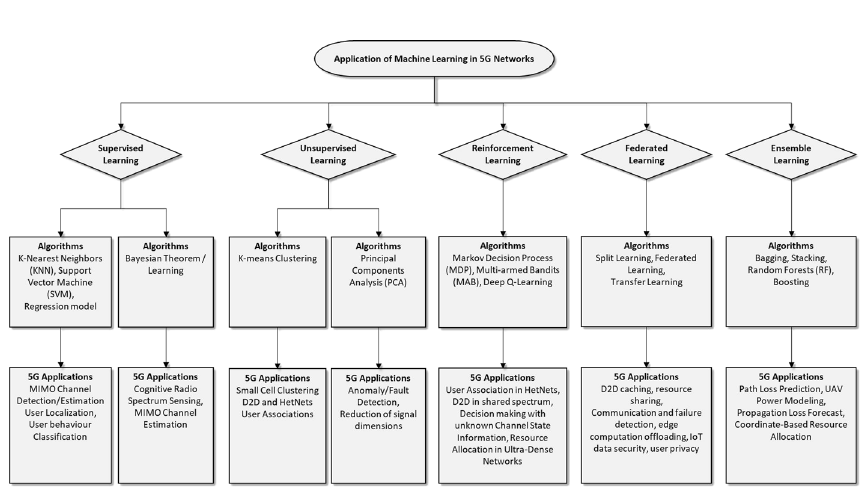
Fig. 2 Machine learning techniques for 5G